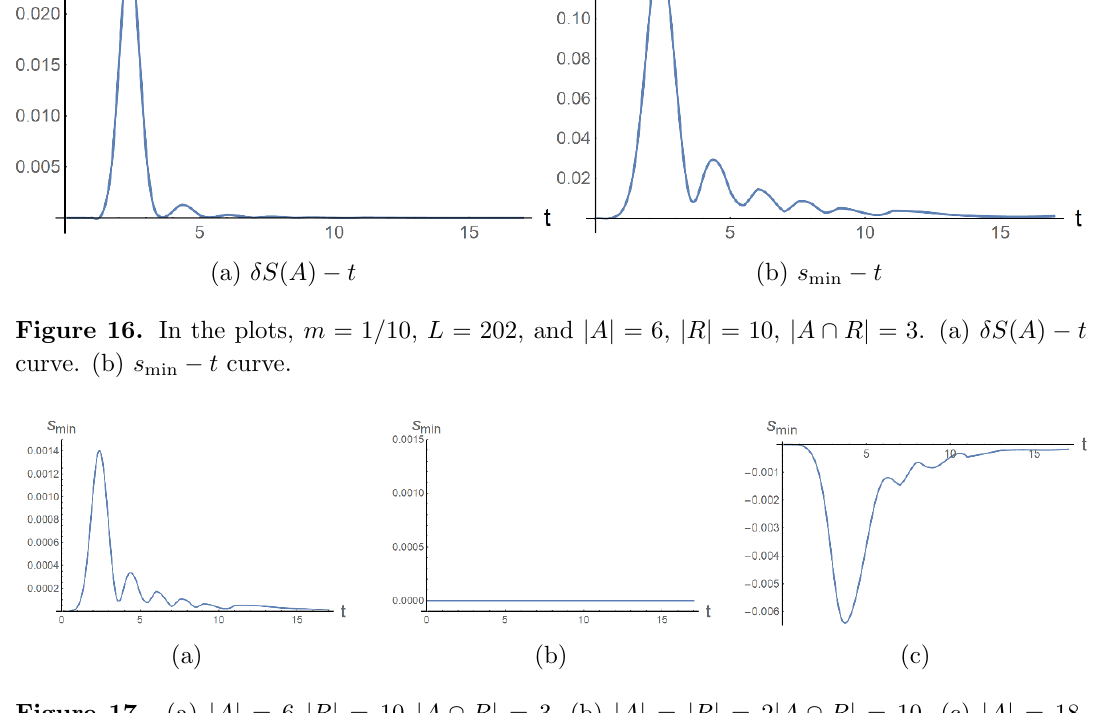
Figure 17. (a) j A j = 6 ; j R j = 10 ; j A \ R j = 3, (b) j A j = j R j = 2 j A \ R j = 10, (c) j A j = 18, j R j = 10 ; j A \ R j = 9. m = 1 = 100 and L = 202 are chosen. As the (cid:12)gure shows, s min is